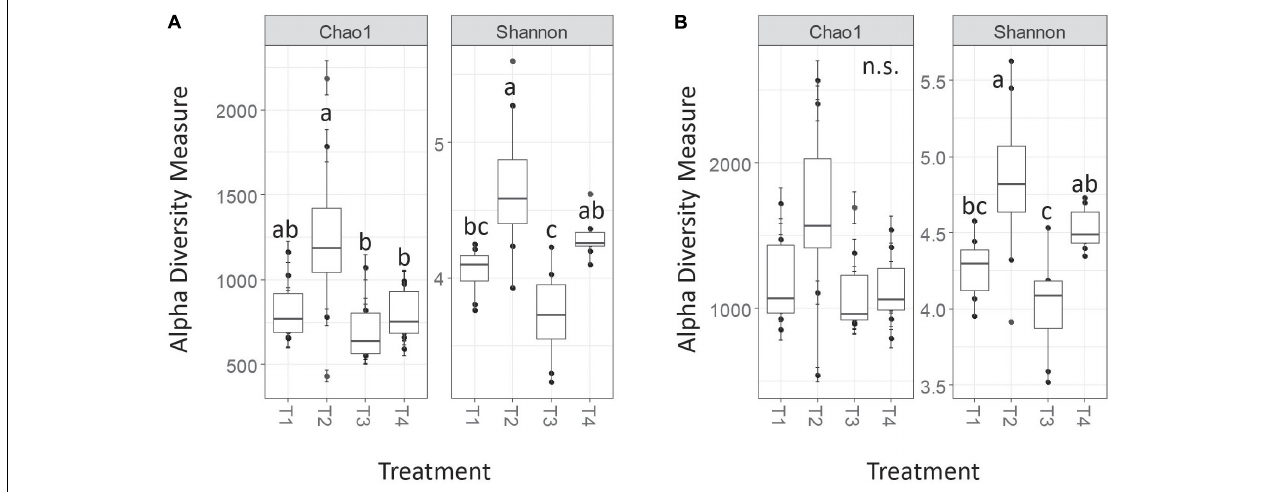
FIGURE 4 | Chao1 and Shannon alpha diversity measures for nrfA for AGC-0.03 (A) and MCC-0.03 (B) methods. Letters indicate significance at α < 0.05 via ANOVA with Tukey’s HSD correction for multiple comparisons.